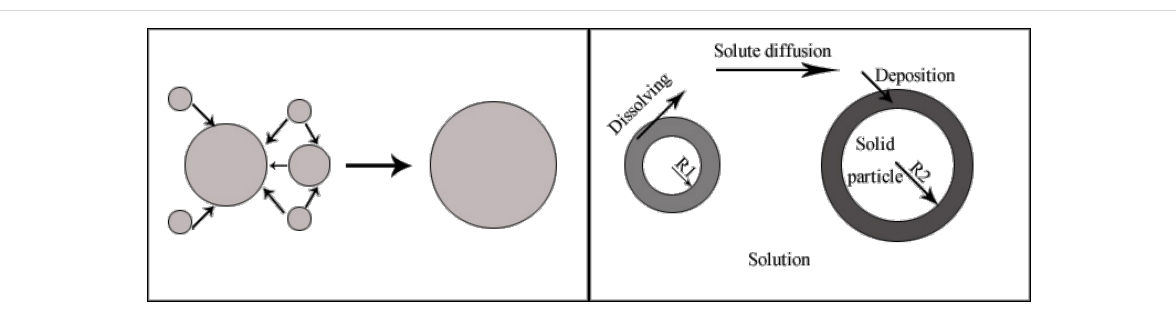
especially important meaning since it is the inflection point between Ni nanoparticles and Ni nanowires in the reaction system and is the key to the mechanism. It can be defined as the